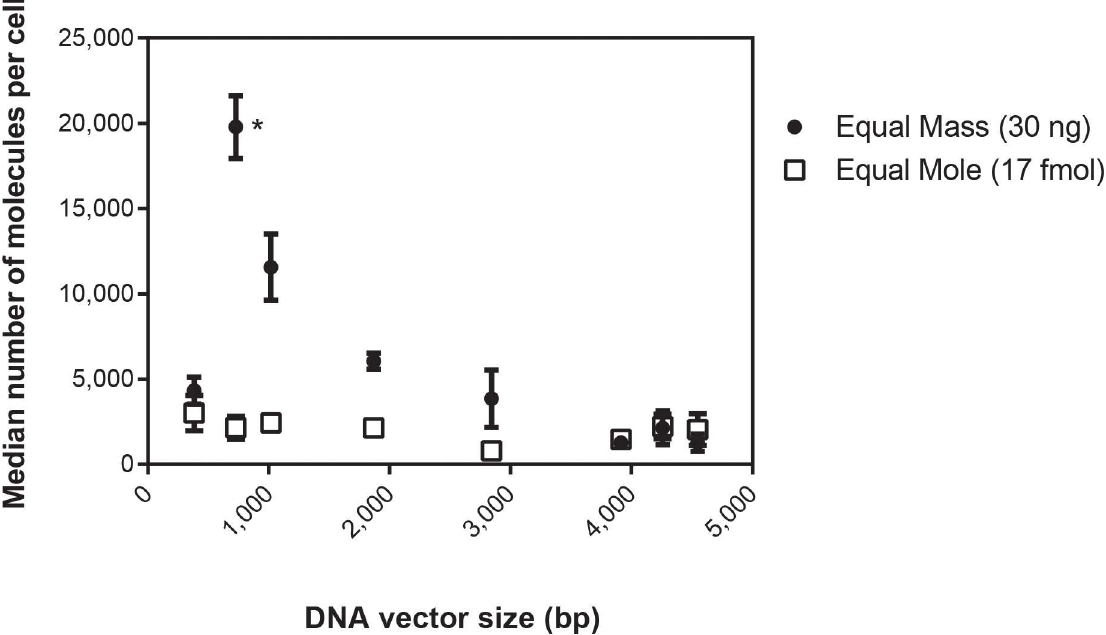
Fig 2. Effect of DNA vector length on cell entry. Each of the DNA vectors was labeledwith Cy3 using LabelIT and transfected into 90,000 HeLa-GFP cells. Cells were transfected using electroporation with 30 ng of each of the eight DNA vectors and the medianCy3 fluorescence was determined using flow cytometry (circles). In a separateexperiment, 90,000 HeLa-GFP cells were transfected with 17 fmol of each of the eight DNA vectors (equivalent to 30 ng of the p2844)(squares). Median Cy3 fluorescence was comparedto a standardcurve of R-PE beads to determinethe numberof fluorophores, which, when combinedwith the numberof Cy3 fluorophores per DNA moleculefor each vector, yieldedthe number of moleculesper cell. * For transfections at equal mass, results for mv727 were statisticallysignificantly higher(by one-wayANOVA) than the results for all the vectors except mv1018.No other pairwisecomparisons were statisticallysignificant.